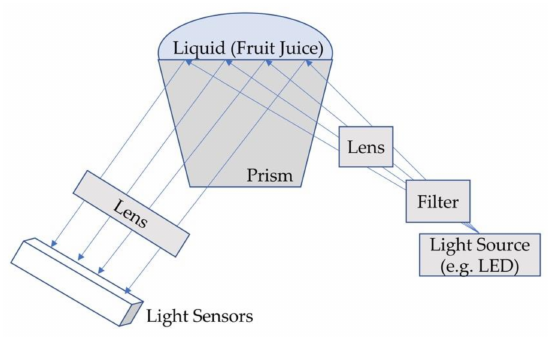
Figure 3. Traditional Refractometer